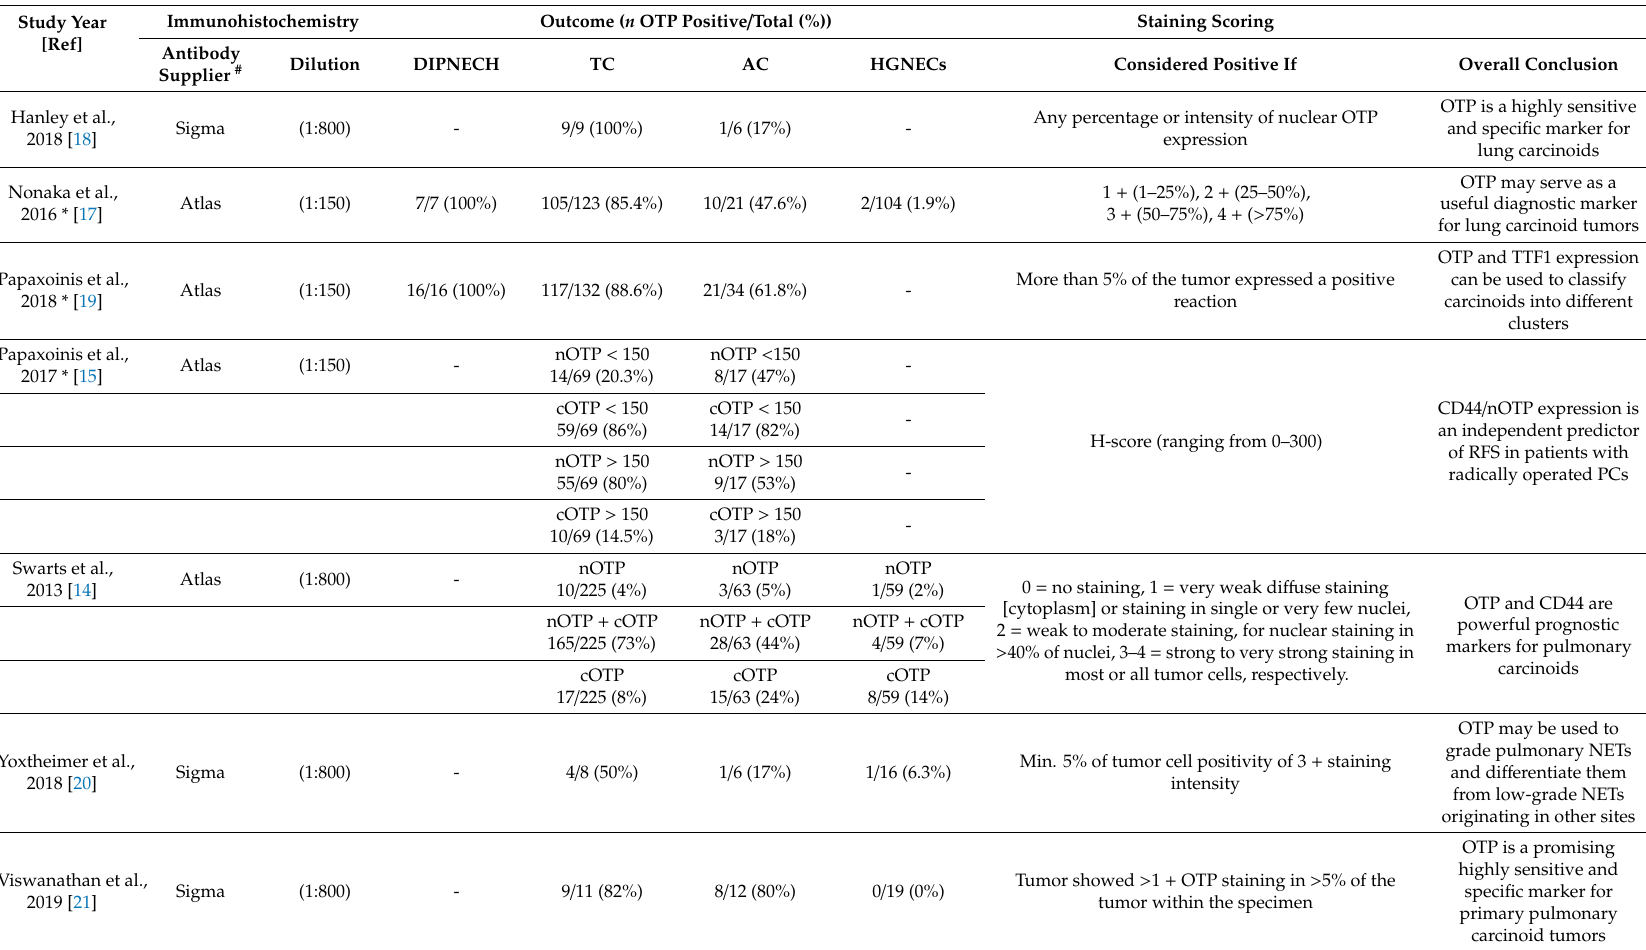
Table 2. Overview of immunohistochemical features of studies that performed OTP